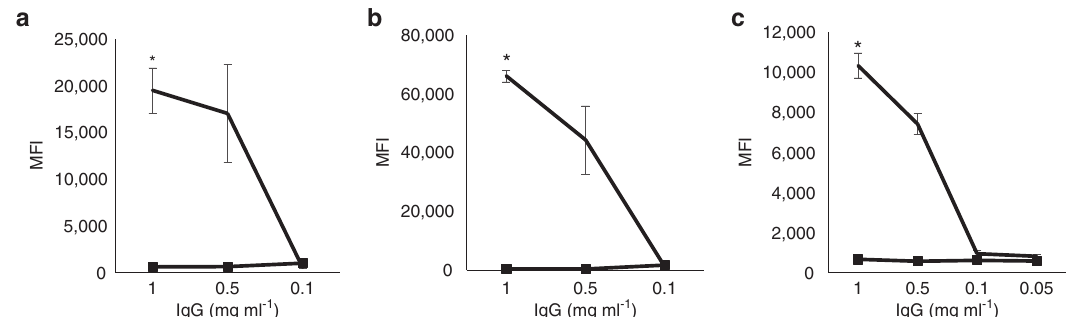
Figure 3 | Antibody-dependent enhancement of VP2-VLPs in primary B cells and in a monocytic cell line. The mean fluorescence intensity (MFI) of VP2-VLP-AF647 was measured by flow cytometry in tonsillar B cells from two seronegative individuals ( a , b ) as well as in U937 cells ( c ) after incubation with B19V-IgG þ (black solid line) or B19V-IgG - (black solid line, squares) total purified preparations. Error bars represent standard deviation (of four replicates). *Represents statistical significance ( P o 0.001) between positive and negative IgGs at a given concentration as calculated by Student’s t -test.